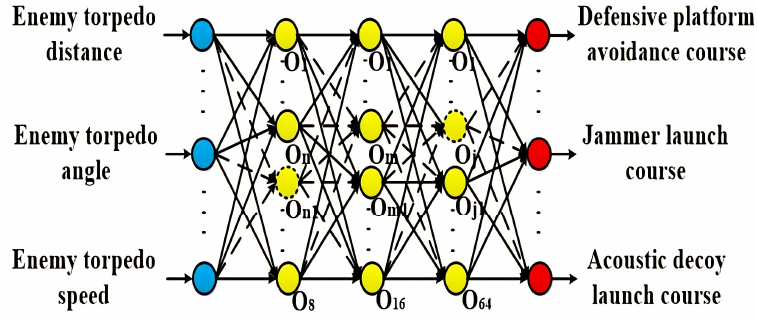
Figure 14. The topology of the optimized GA ‐ BP neural network.